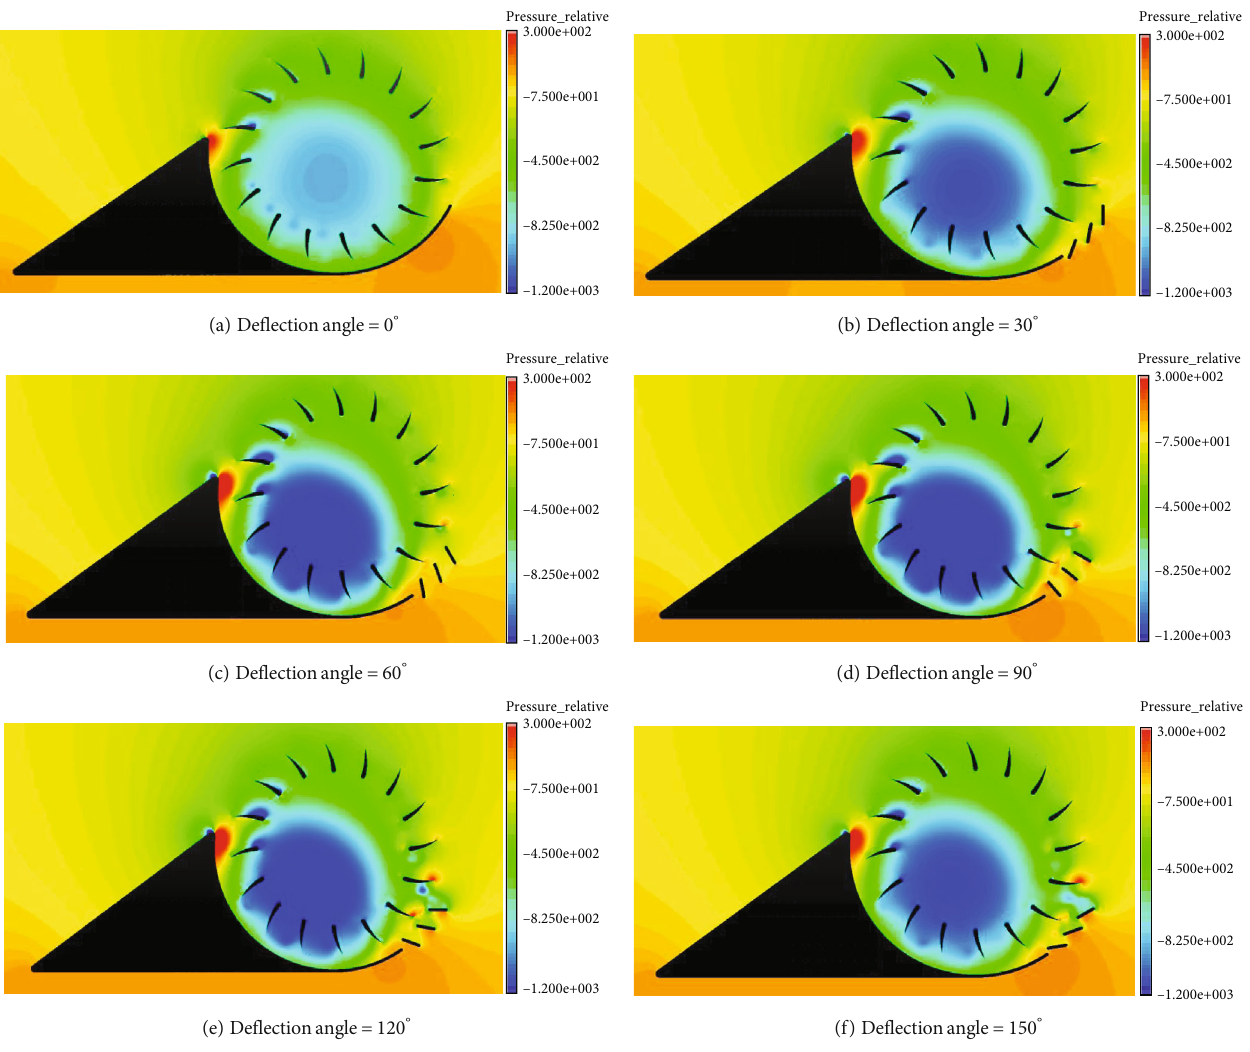
Figure 18: Pressure nephogram of triple leading edge winglet ( v = 12 m/s , α = 0 ° ).